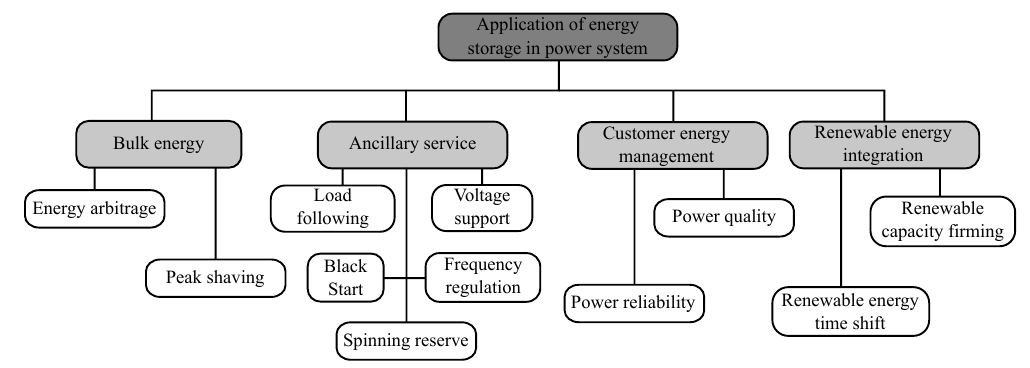
Figure 1. Overview of the main applications of energy storage systems (ESSs) [6].